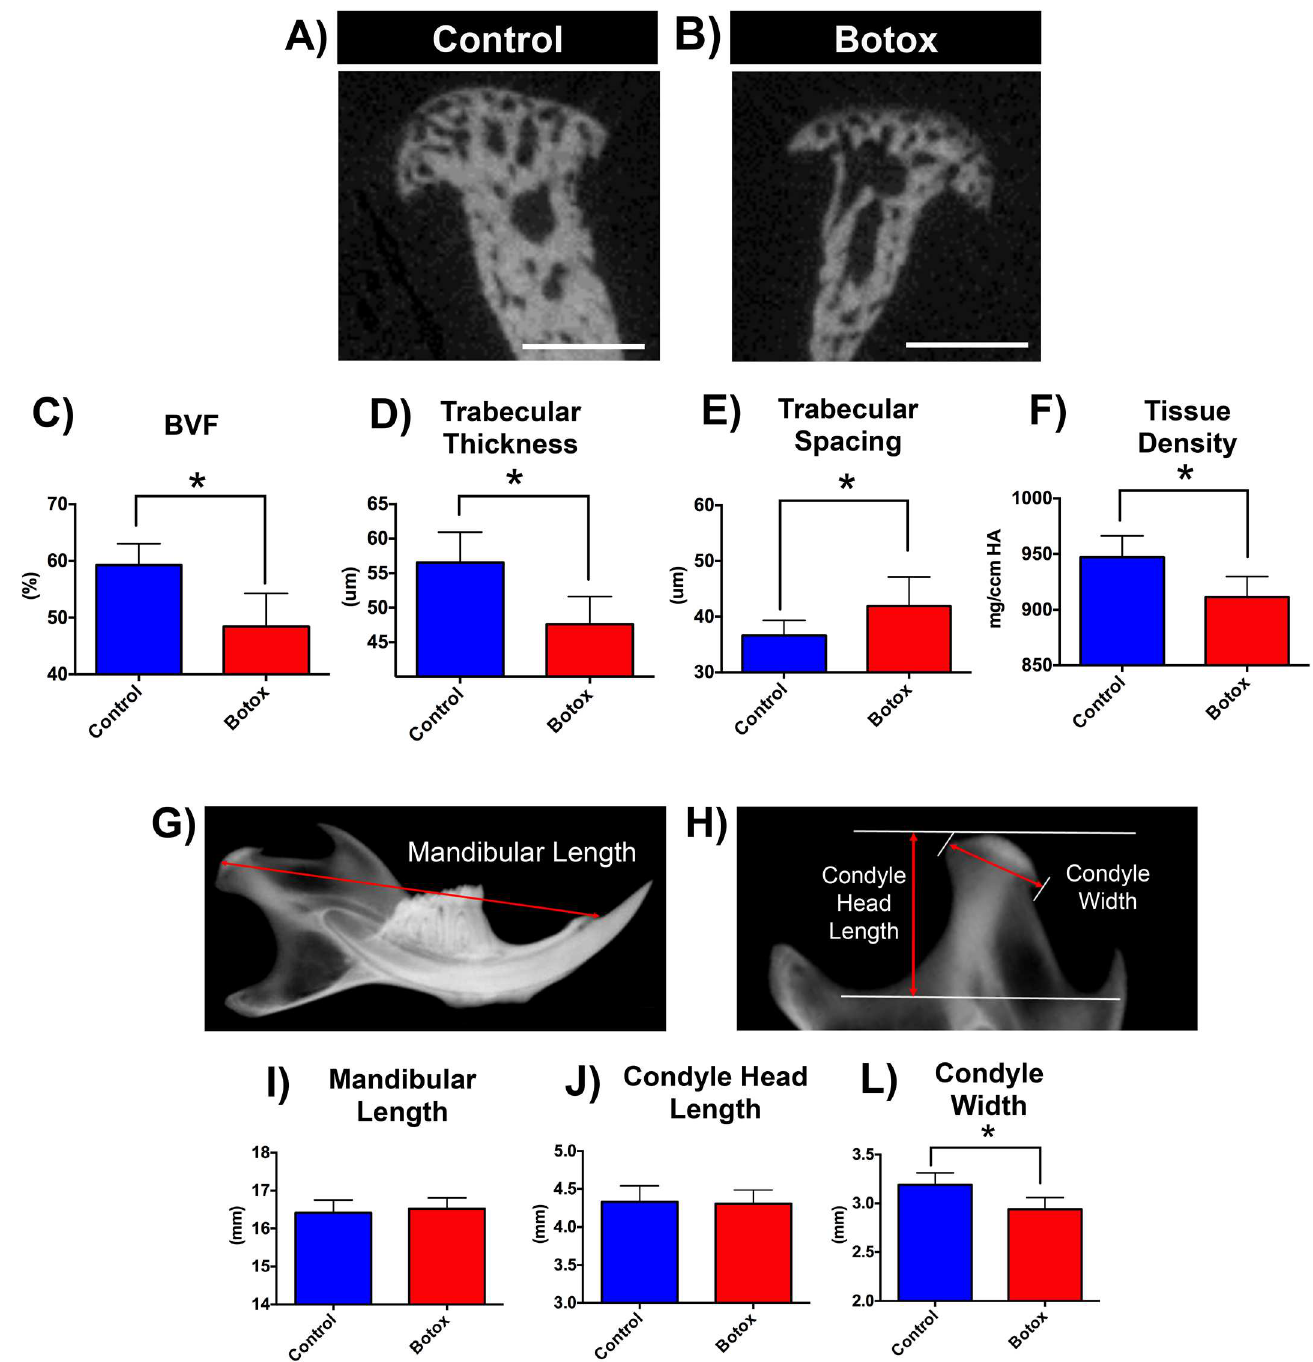
Fig 1. Reduced bone volume and density and reduced condyle width at the Botox injected side. Coronal micro-CT images of condyles of control (A) and Botox (B) injected side masseter 4 weeks after unilateralBotox injection. Quantification of bone parameters: C) BVF—bone volume fraction, D ) Trabecular Thickness, E) Trabecular Spacing, F) Tissue Density. Morphometric measurements (G-H) performed in Faxitron xray images of control and Botox injected side mandibles: I) MandibularLengh, J) CondyleHead Length, L) CondyleWidth. Histograms (C-F, I-L) represent means ± SD for n = 13 per group . * S ignificant difference between control and Botox injected side (p < 0.05). Scale bar = 500 μ m.